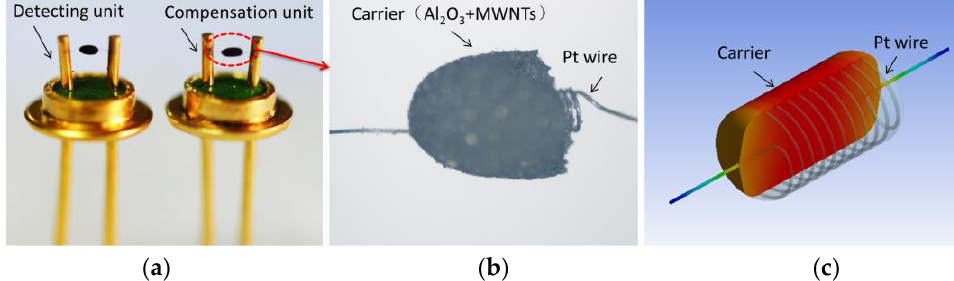
Figure 1. The element structure. ( a ) A pair of elements for the sensor. ( b ) Carrier bead structure. ( c ) Carrier bead cross-section.